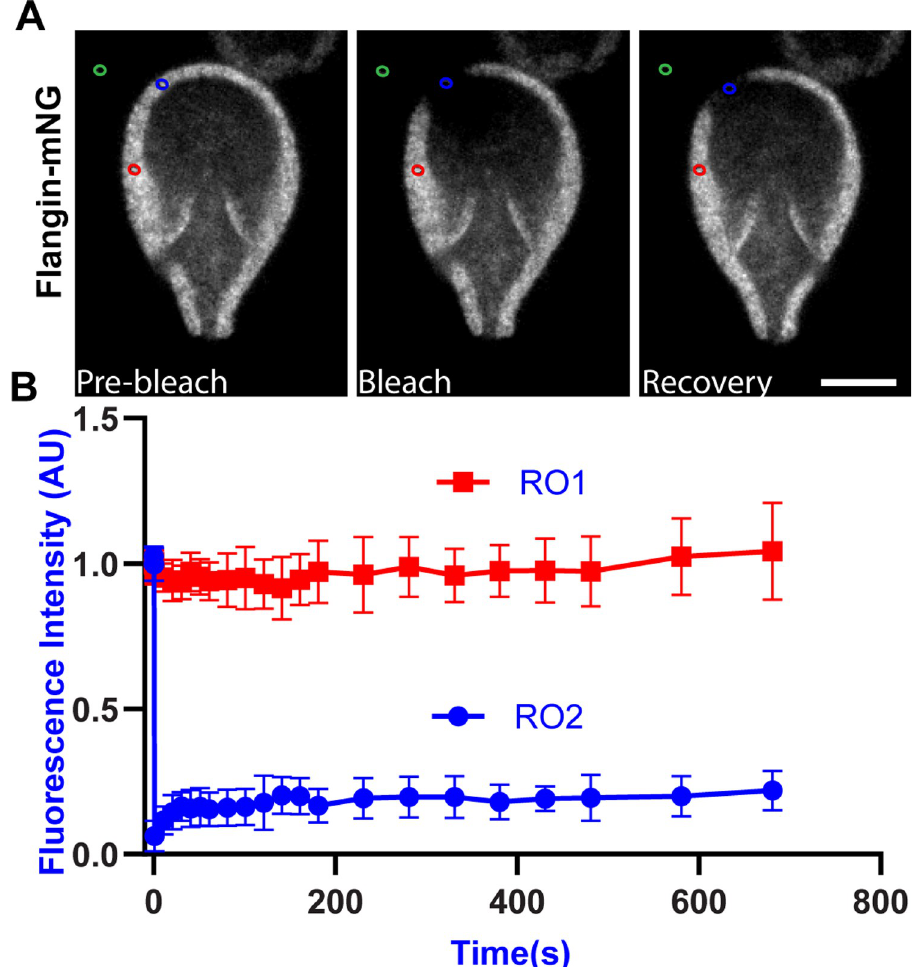
Fig 3. Flangin is part of a stable structure. (A) Fluorescence Recovery after Photobleaching (FRAP) was performed on the flange of Flangin-mNG cells, Blue circle bleached ROI 01, Red circle non-bleached ROI 02, and Green circle background ROI 03. (B) ROI 01 showed minimal post-bleaching recovery after 12min, n = 4 independent experiments. A lack of fluorescence recovery was also observed in 29 additional FRAP experiments of various lengths and regions of the cell including the small membrane protrusion associated with the posterolateral axonemes. Scale bar = 5 μ m. See S3 Movie for confirmation of